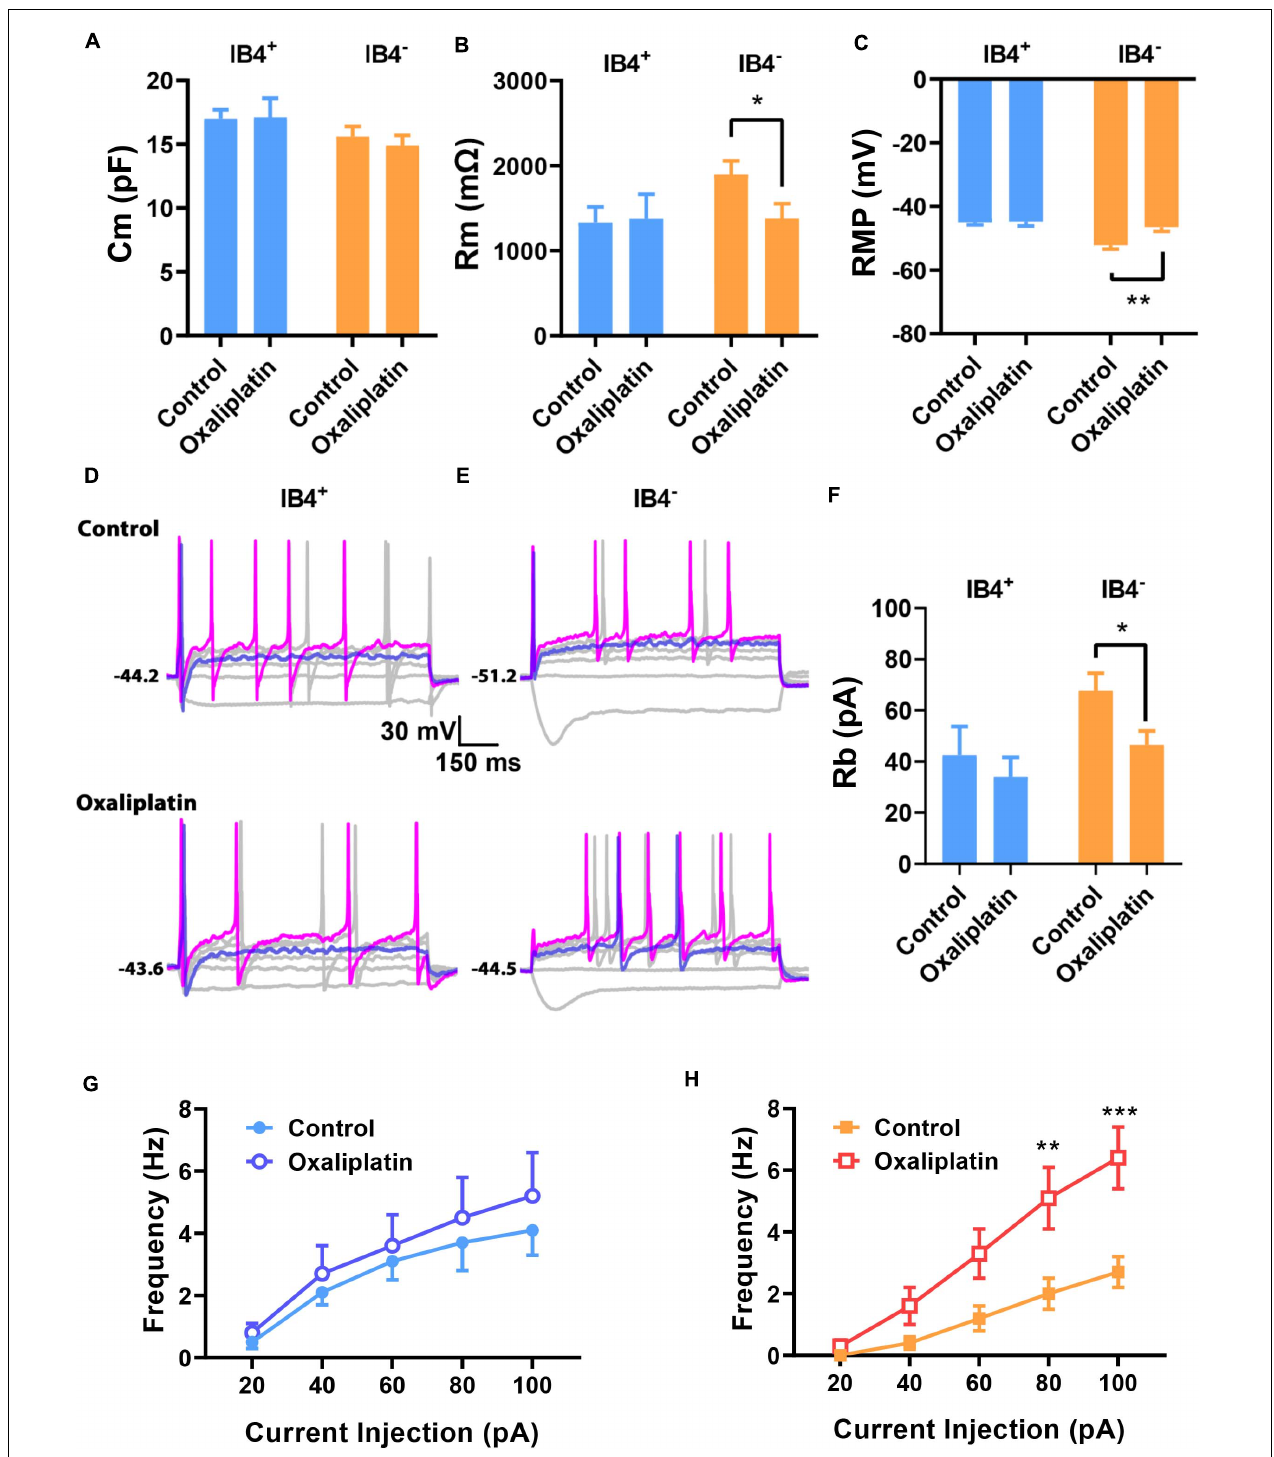
FIGURE 2 | Effects of oxaliplatin on the electrophysiological properties of IB4 + and IB4 − subpopulations of small DRG neurons. Oxaliplatin (50 µ M) was pre-treated in the recording chamber for 15–60 min. The passive and active properties of IB4 + and IB4 − subpopulations of small DRG neurons were recorded and presented in the same way described in the legend of Figure 1 . Oxaliplatin did not change the Cm of both IB4 + and IB4 − neurons (A) but decreased the Rm (B) and depolarized the RMP (C) in IB4 − neurons; (D,E) Representative recordings from IB4 + or IB4 − DRG neurons in the absence or presence of oxaliplatin, respectively. (F) The effect of oxaliplatin on rheobase of IB4 + and IB4 − neurons. (G,H) The effect of oxaliplatin on the firing frequency of IB4 + (G) and IB4 − (H) neurons, respectively. n = 8–14 for each group (see detailed numbers for each group in results). * P < 0.05, ** P < 0.01, *** P < 0.001, Student’s t -test (B,C,F) or Two-way repeated measure ANOVA (H)